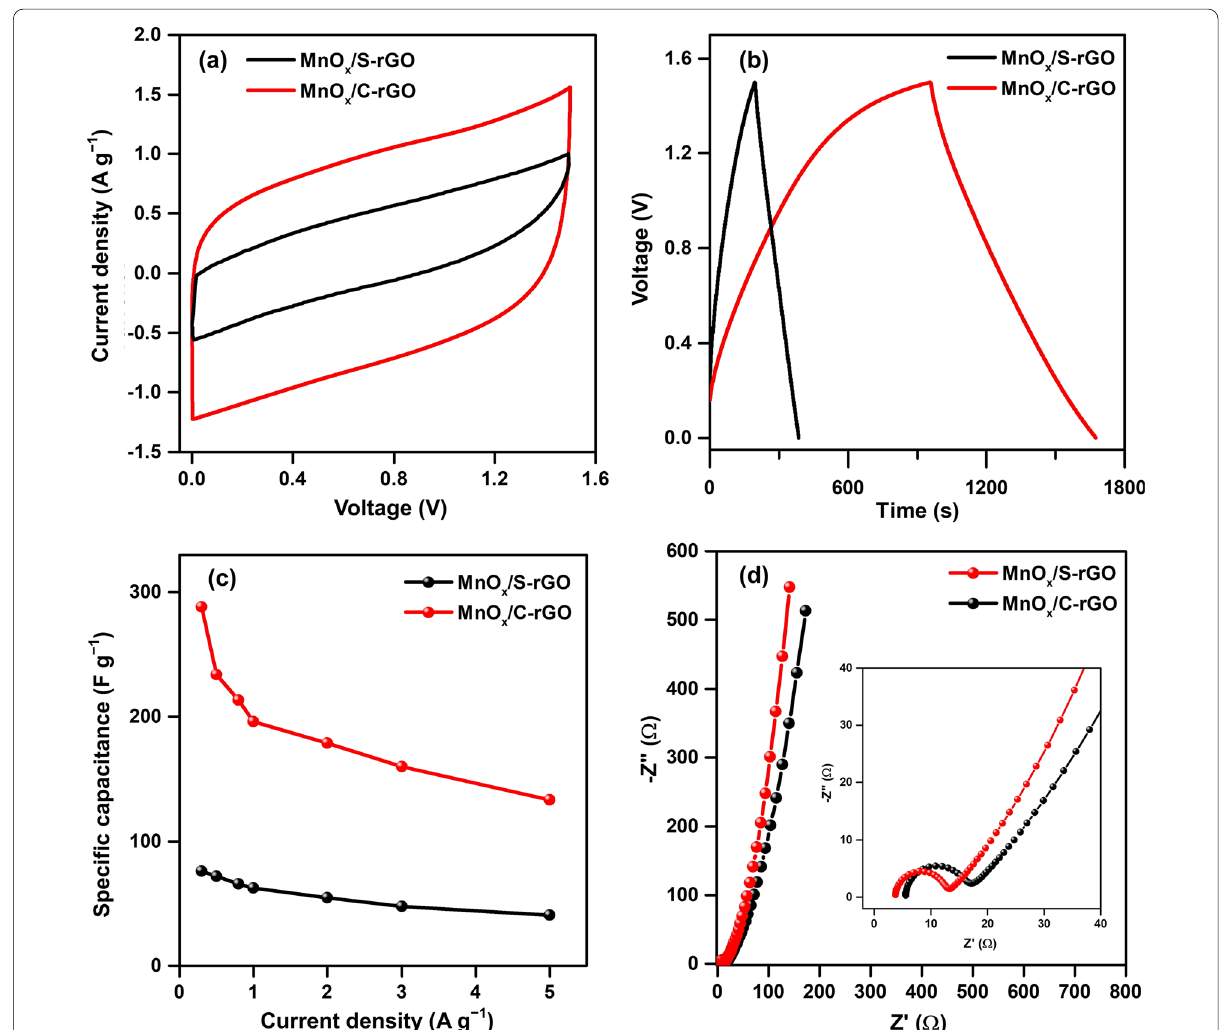
Fig. 4 Two-electrode system measurements: a CV curves at a scan rate of 20 mV s − 1 ; b GCD curves at a current density of 0.3 A g − 1 ; c Specific capacitances of symmetric devices based on MnO x /S-rGO and MnO x /C-rGO at different current densities, and d Nyquist plots of symmetric devices based on